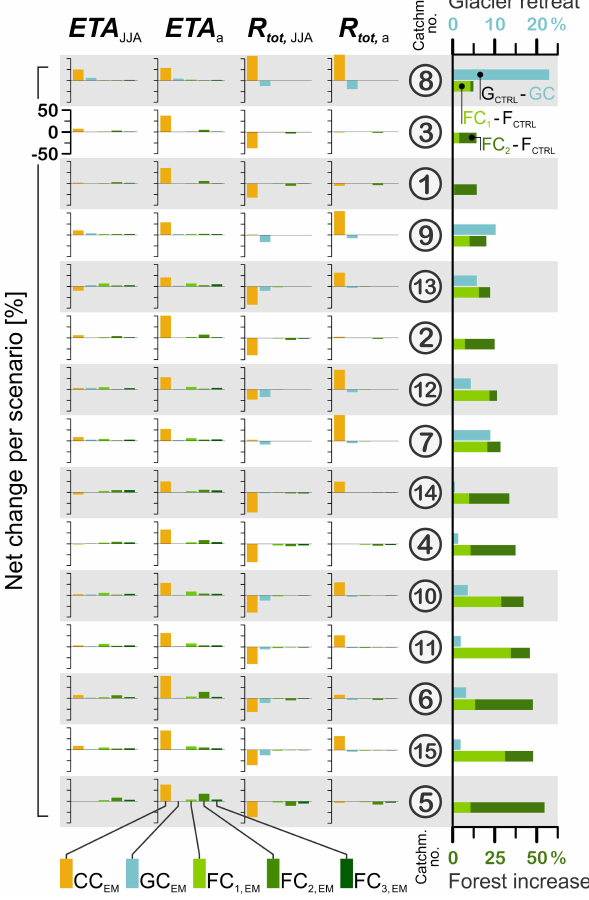
Fig. 6. Comparison of relative net changes per scenario (CC EM , GC EM , FC 1, EM –FC 3, EM ) and catchment. The first column (left) displays results for summer evapotranspiration (ETA JJA ) , the sec- ond those for annual evapotranspiration (ETA a ) , the third column depicts summer total runoff ( R tot JJA ) , the fourth (right) annual total runoff ( R tot a ) . The scale is the same for each panel, ranging from − 50–50% (indicated for ETA JJA , catchment 3). The catchments are sorted from top to bottom according to increasing forest change be- tween CTRL and the combined forest increase of FC 1 (light green bars) and FC 2 (dark green bars), see right panel of the figure. The relative glacier retreat in per cent catchment area is added to the right panel, too (light blue